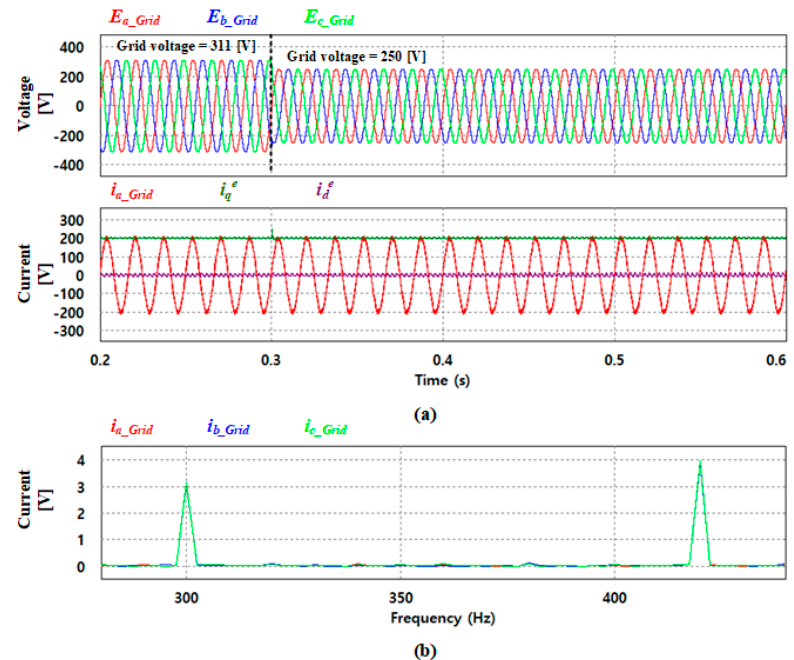
Figure 16. Conventional harmonic compensation method (grid voltage: 311 V  250 V): ( a ) three-